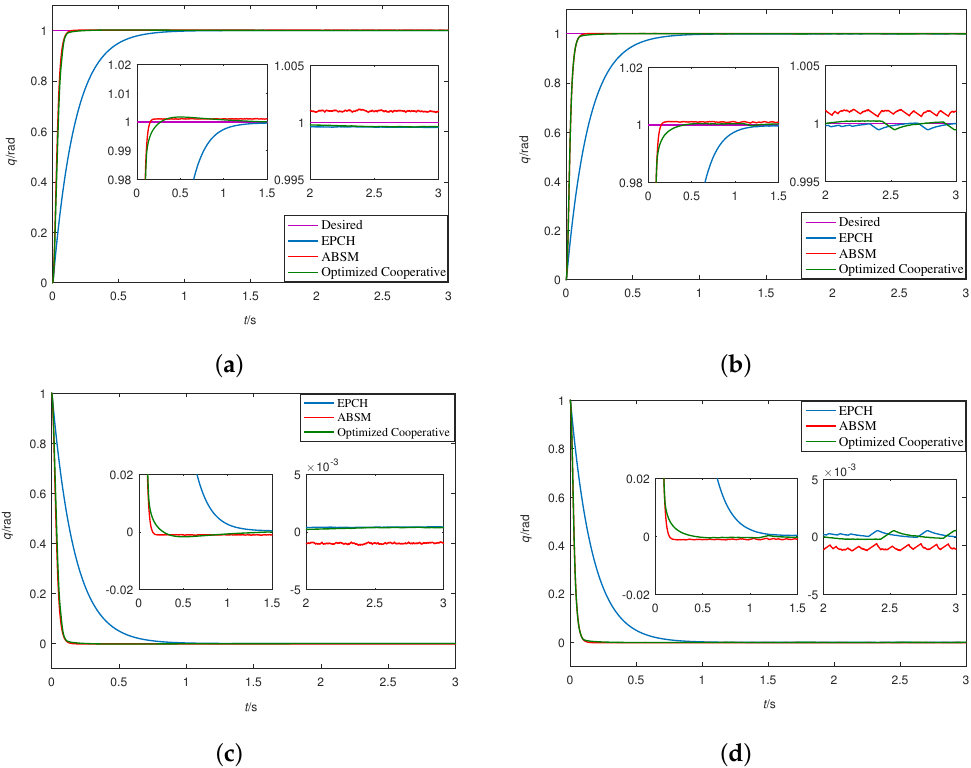
Figure 7. Position tracking curve and tracking error curve of two joints under the three control methods. ( a ) Position tracking curve of Joint 1. ( b ) Position tracking curve of Joint 2. ( c ) Tracking error curve of Joint 1. ( d ) Tracking error curve of Joint 2.